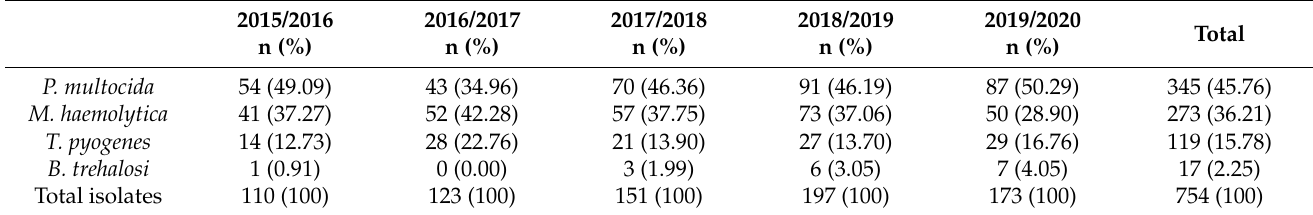
Table 1. Species, absolute and (relative) number of isolates investigated in the present study over the five-year period